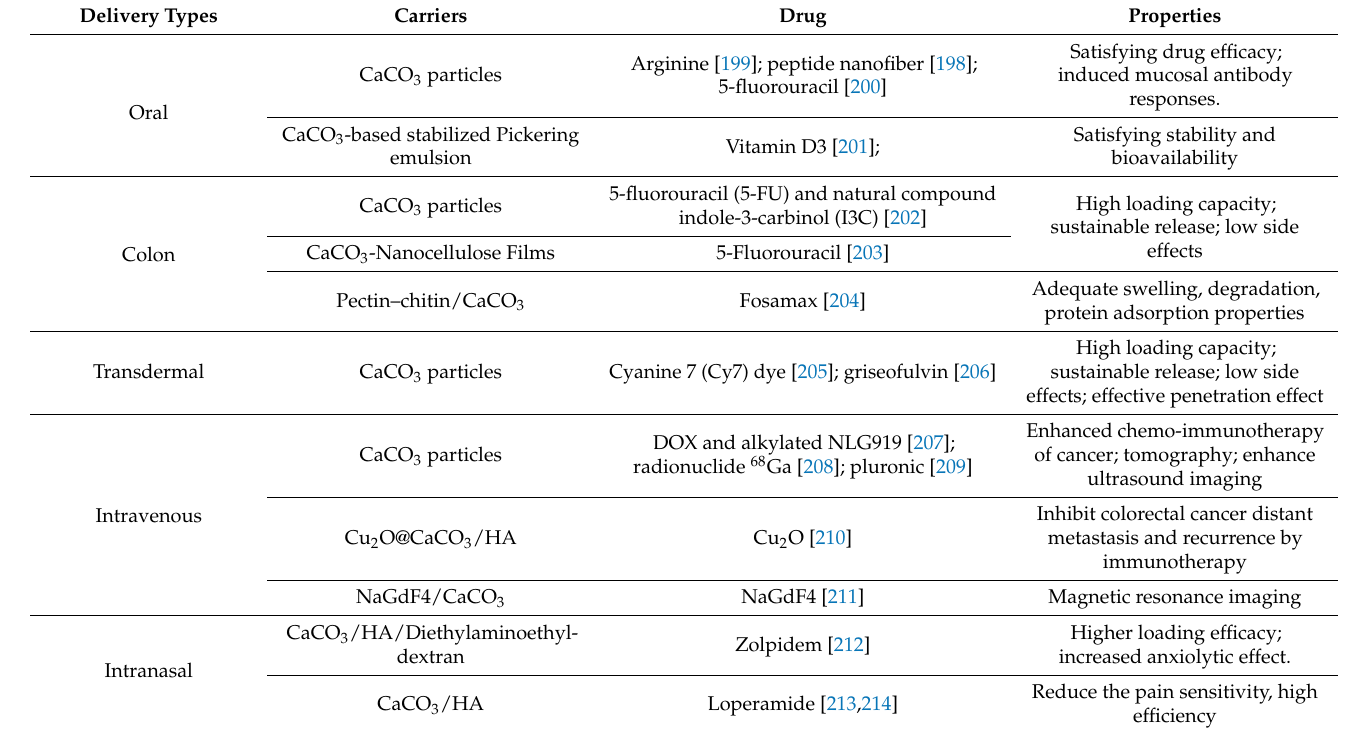
Table 4. Various CaCO 3 -based carriers used in drug